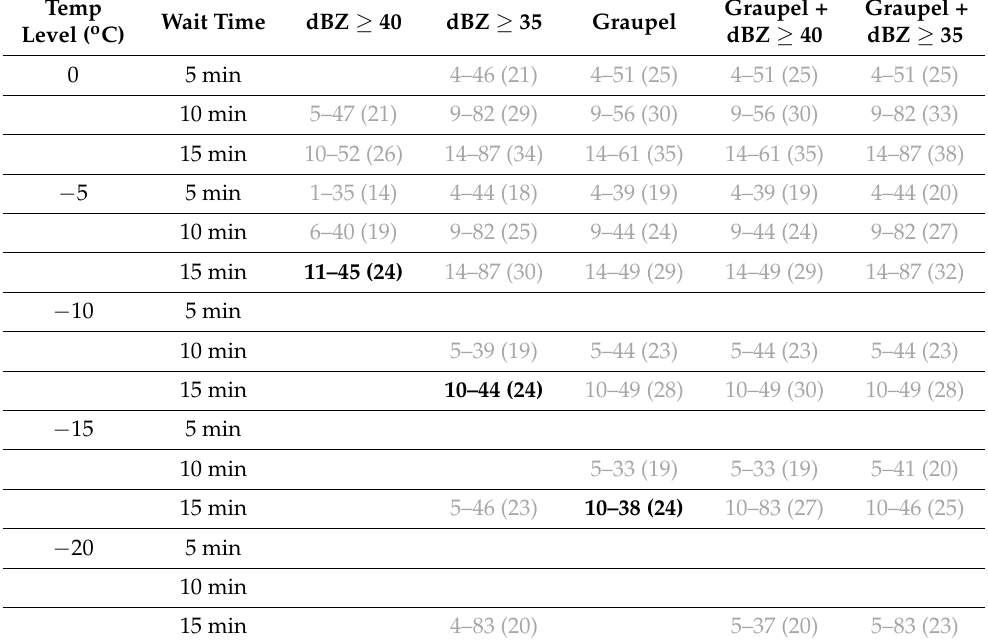
Table 5. This table shows the range and average lightning advisory cancellation time (min) for each cessation algorithm. The format is as follows: minimum-maximum (average). Advisory cancellation times are based on the time of the last flash (t = 0). The values in boldface represent cessation algorithms with the best range of cancellation times (10–45 min after the lash flash). Values in gray represent algorithms with cancellation times that fell outside of this range. Cancellation times were not calculated for cessation algorithms with a CSI < 1.00 (missing